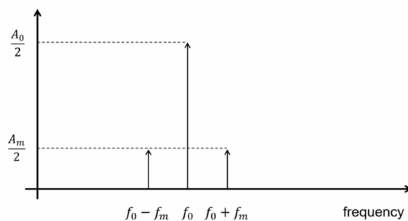
Figure 1. Positive-side amplitude spectrum of a sinusoidal signal amplitude-modulated by a sinusoidal